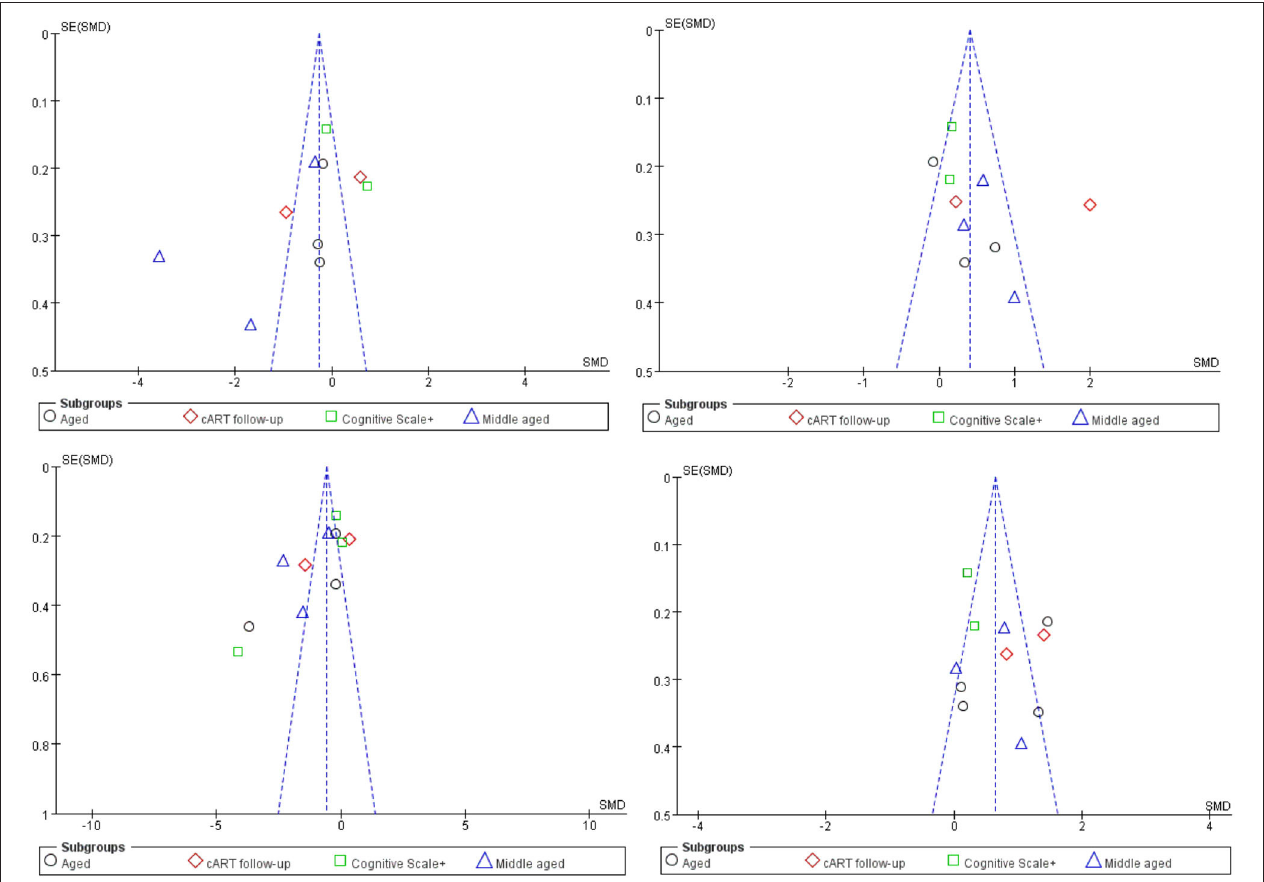
FIGURE 4 | Funnel plot of meta-analysis results. These four figures represent FA in CC, MD in CC, FA among other WMF, MD among other